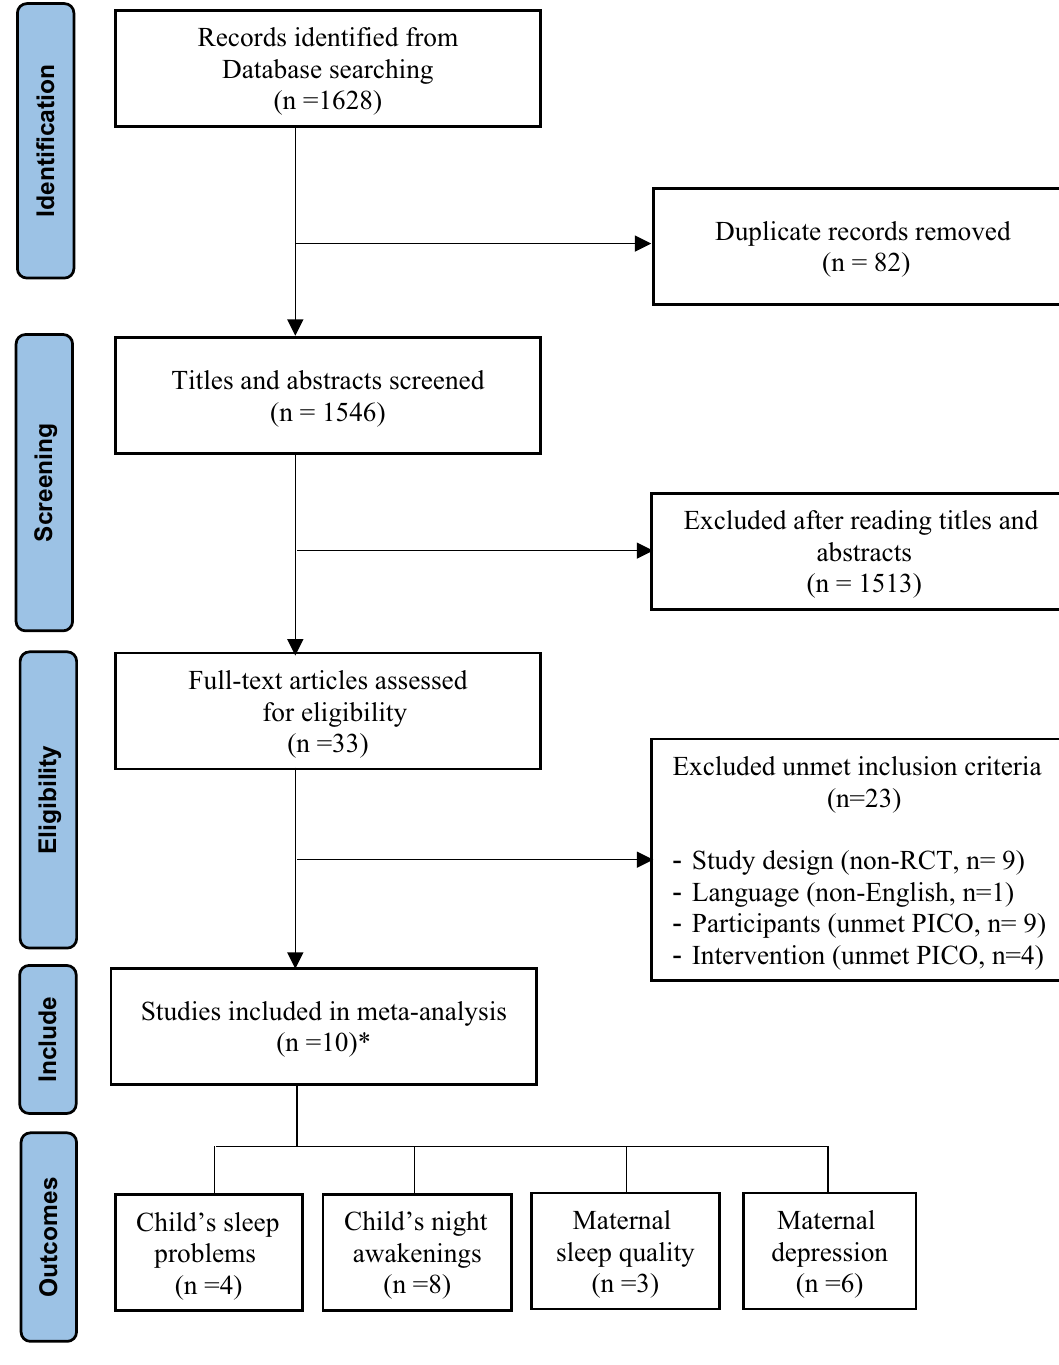
Figure 1. Flow chart of study